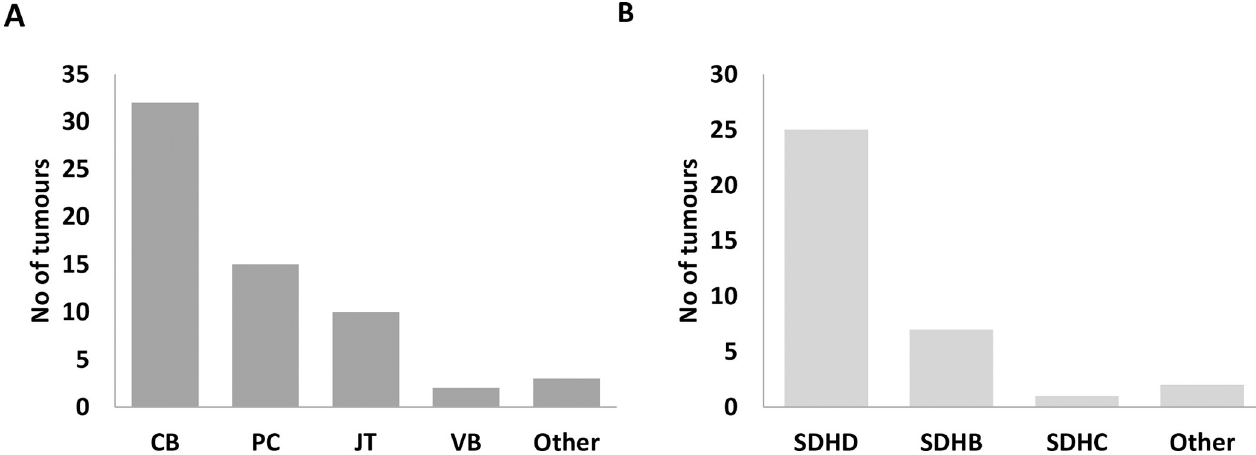
Fig 1. Tissue of origin (panel A) and gene variant (panel B) (if known) of the tumours cultured in this study. CB, carotid body tumour; PPGL, pheochromocytoma/extra-adrenal paraganglioma; JT, jugulotympanic tumour; VB, vagal body tumour.